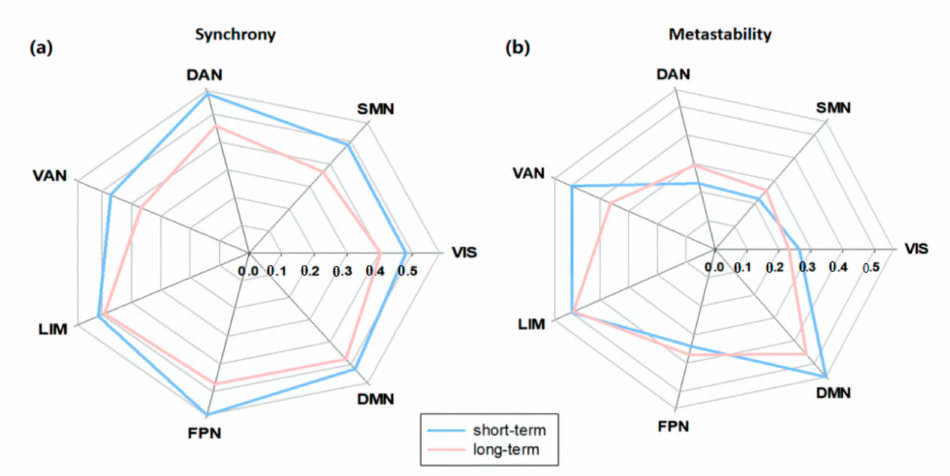
Figure 7. Reliabilities of synchrony ( a ) and metastability ( b ) in different resting-state networks, evaluated by the intraclass correlation coefficient (ICC). Blue lines represent short-term reliability and pink lines represent long-term